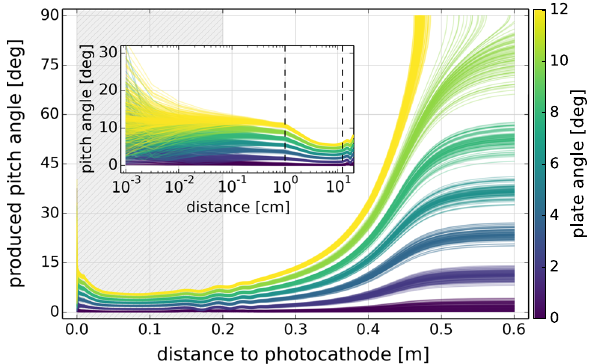
Fig. 14 Simulated pitch angle transformation between the photocath- ode and the spectrometer entrance magnet for different plate angles α = 0 ◦ − 10 ◦ . The plot shows the evolution of the pitch angle θ as p a function of the distance d from the photocathode. The initial pitch angles are cos θ -distributed and collimated into a narrow distribution by the strong electric acceleration field at d (cid:3) 1cm. For α p ≥ 10 ◦ , electrons are magnetically reflected before reaching the magnet. The inset uses a logarithmic axis to focus on the conditions close to the photocathode where the non-adiabatic acceleration takes place; this is indicated by the shaded region in the main plot. The dashed lines mark the position of the front plate ( d = 1cm) and the end of the electron source cage ( d = 12 .